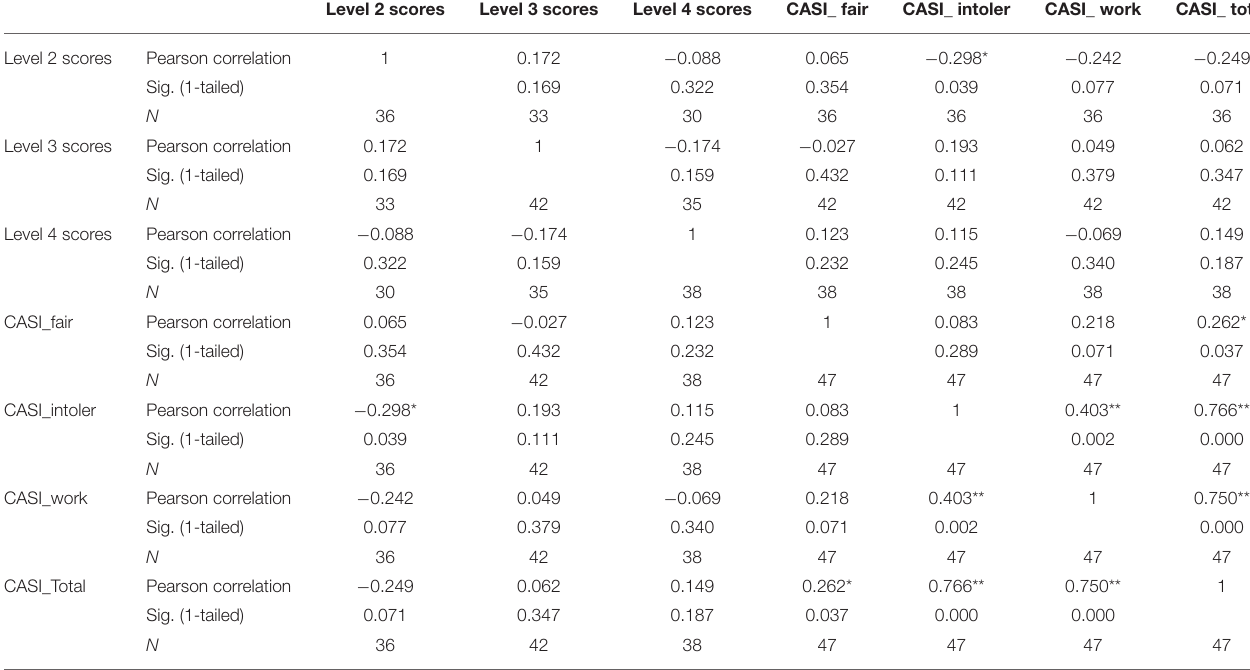
TABLE 4 | Correlation analysis on Level 2, 3, and 4 scores.